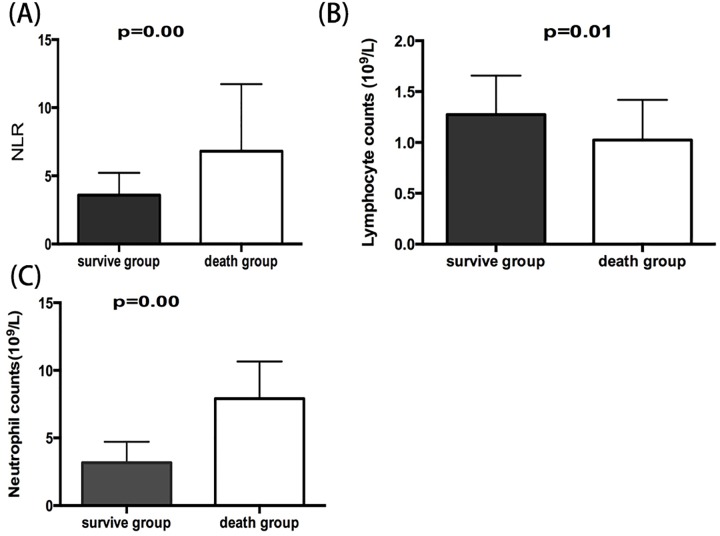
Baseline median NLR (A), LC (B), and NC (C) in the ALSS group survivors (solid bars) and in patients who died (open bars). Error bars are IQRs.